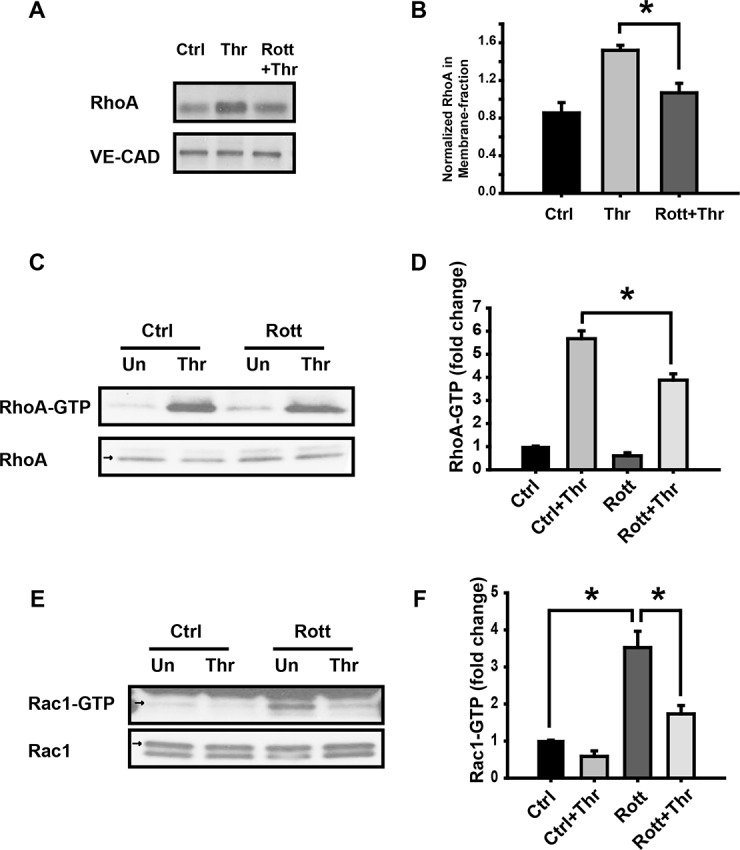
Effect of PKCδ inhibition on thrombin-induced changes in Rho and Rac GTPase activity.EC were pretreated with rottlerin (10 μM, 30 min) followed by exposure to thrombin (1 U/ml, 5 min). Unstimulated cells (Un) were used as controls. (A) Membrane fractions were immunoblotted with RhoA and VE-Cadherin specific antibodies. (B) Normalized densitometry of RhoA in membrane fraction is shown. (C) Activated RhoA (RhoA-GTP) was determined as described in the methods. (D) Normalized RhoA activity based on densitometric analysis is shown. (E) Using the same experimental conditions, Rac1 activation (Rac1-GTP) was determined as described in the methods. (F) Normalized Rac1 activity based on densitometric analysis is shown. n≥ 3/condition, * p < 0.05.